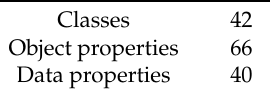
Table 1. Metrics of the resulting ontology, “DCFOAF_merged.owl”.